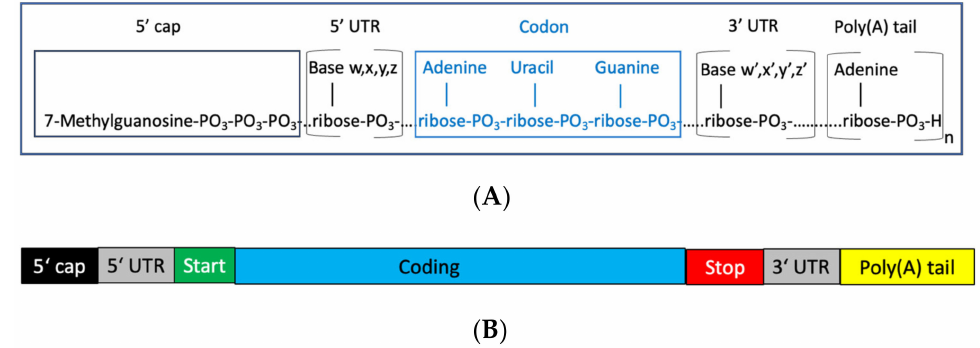
Figure 1. ( A ): General structure of mRNA containing the four nucleobases adenine, cystine, guanine, and uracil, linked to ribose. The resulting nucleosides are connected via phosphate groups. The starting (5 (cid:48) cap) position is formed by 7-methylguanosine with a three-phosphate moiety as a linker to the first nucleotide. At the end of the molecule, multiple adenosine moieties are attached. A codon comprises three nucleotides, for example, AUG, which is the code for methionine. ( B ): Functional structure of mRNA; details of functions are provided in Table 1. 5 (cid:48) UTR: 5 (cid:48) untranslated region. 3 (cid:48) UTR: 3 (cid:48) untranslated region. Poly(A)tail: multiple adenosine